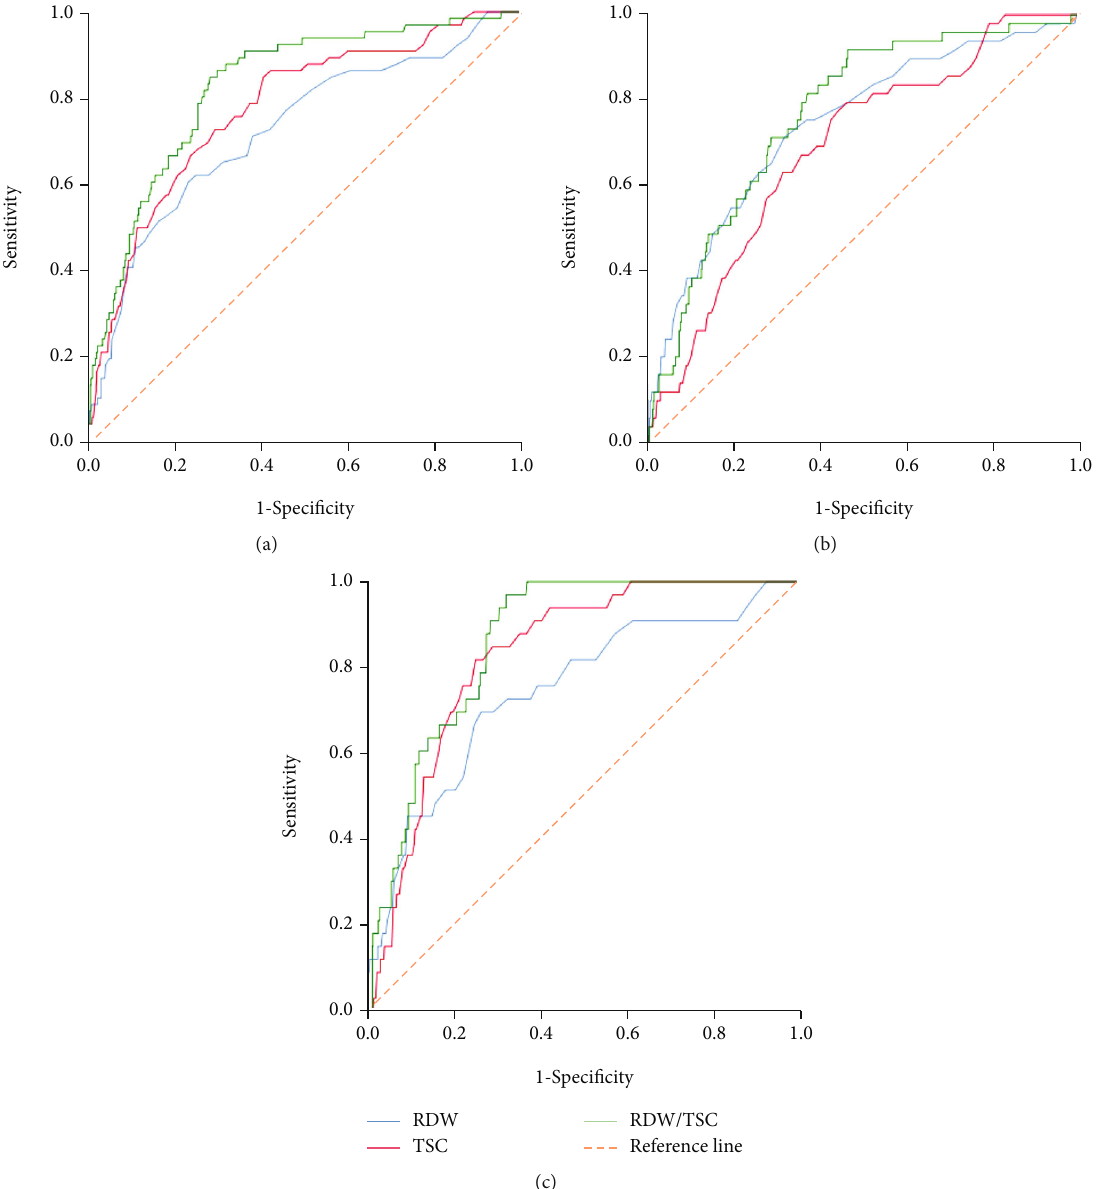
Figure 1: (a) ROC curves analysis for predicting admission to ICU by of RDW, TSC, and RDW/TSC. (b) ROC curves analysis for predicting surgery need by of RDW, TSC, and RDW/TSC. (c) ROC curves analysis for predicting hospital mortality by of RDW, TSC, and